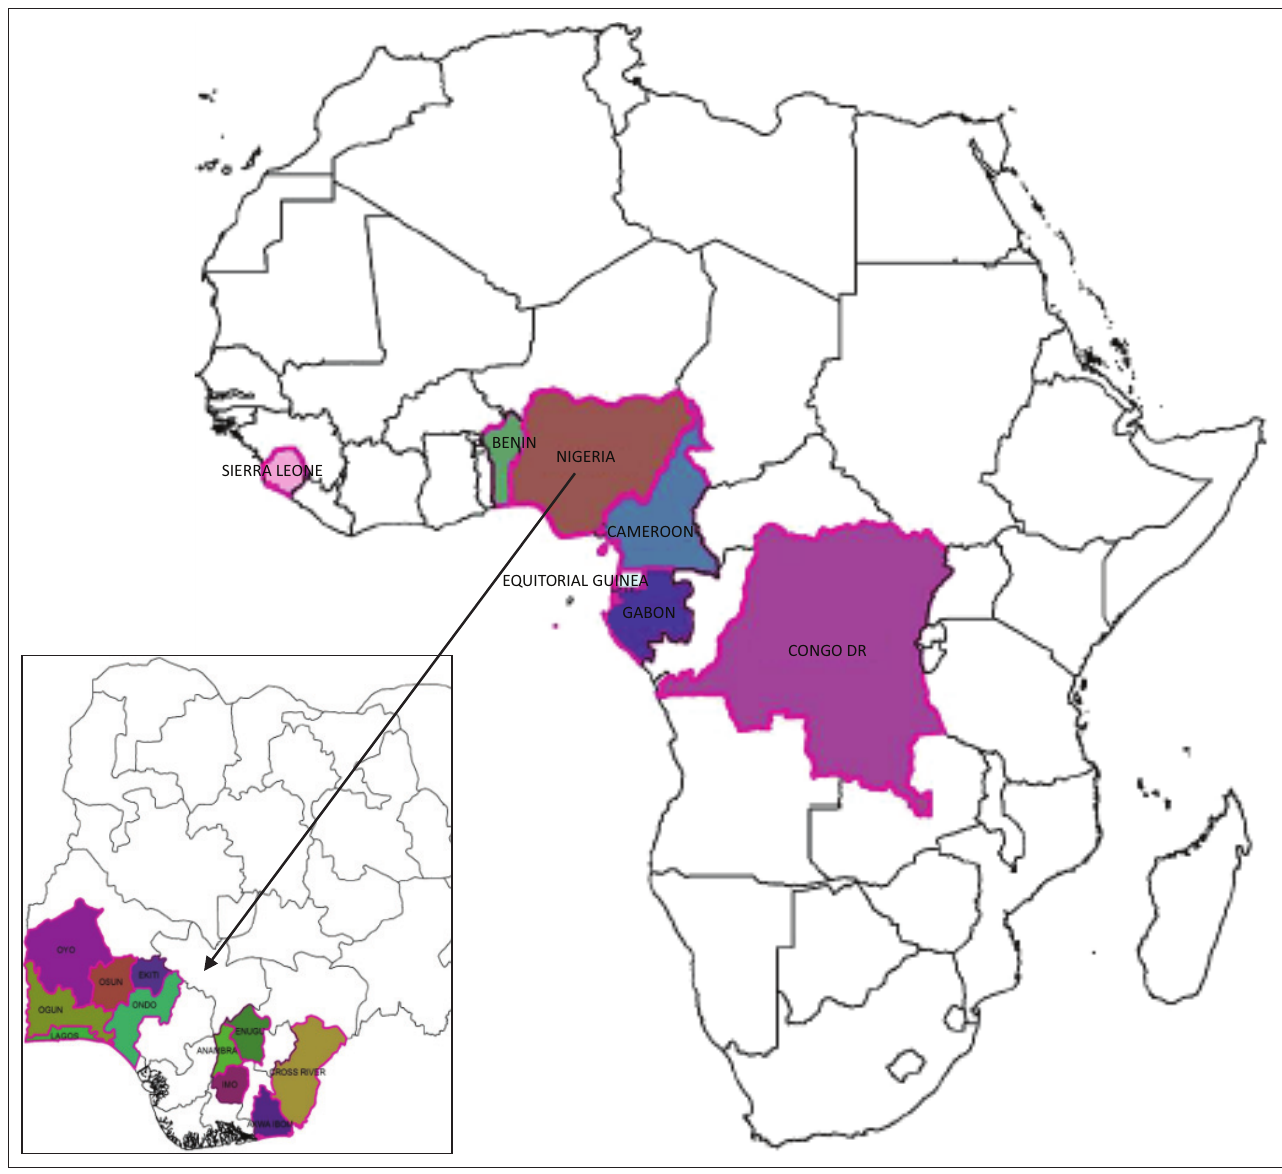
FIGURE 2: Geographical distribution of walnut-producing countries in Africa and